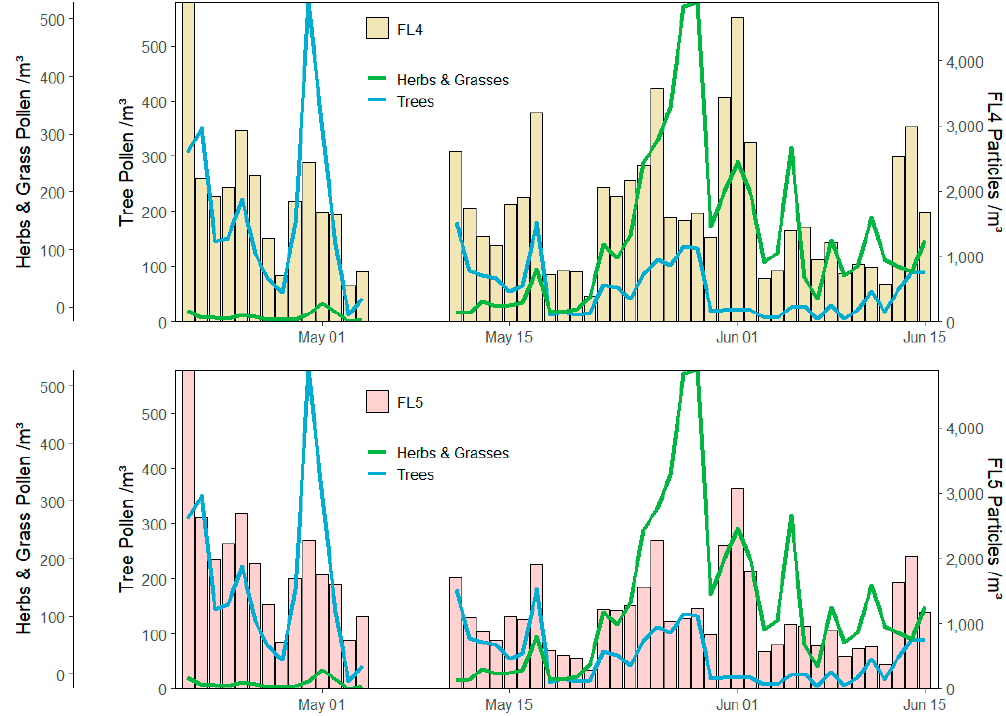
Figure 8. Daily distributions of select pollen classes and FL4/FL5 fluorescent particles.